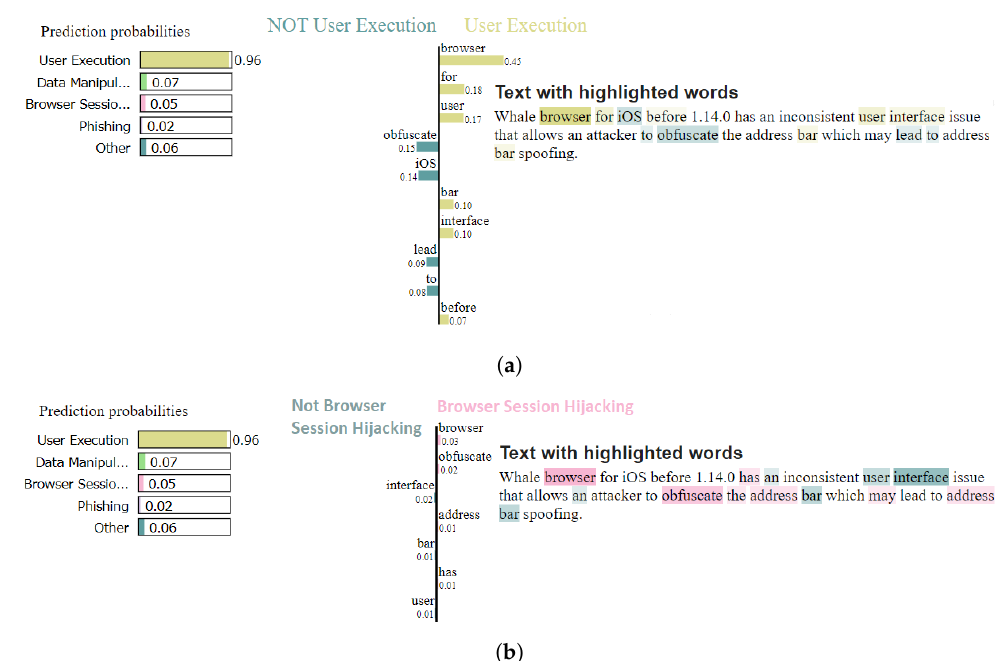
Figure 11. Comparison of word mappings for each technique corresponding to CVE #4 from Table 4. ( a ) Mapping User Execution technique; ( b ) Mapping Browser Session